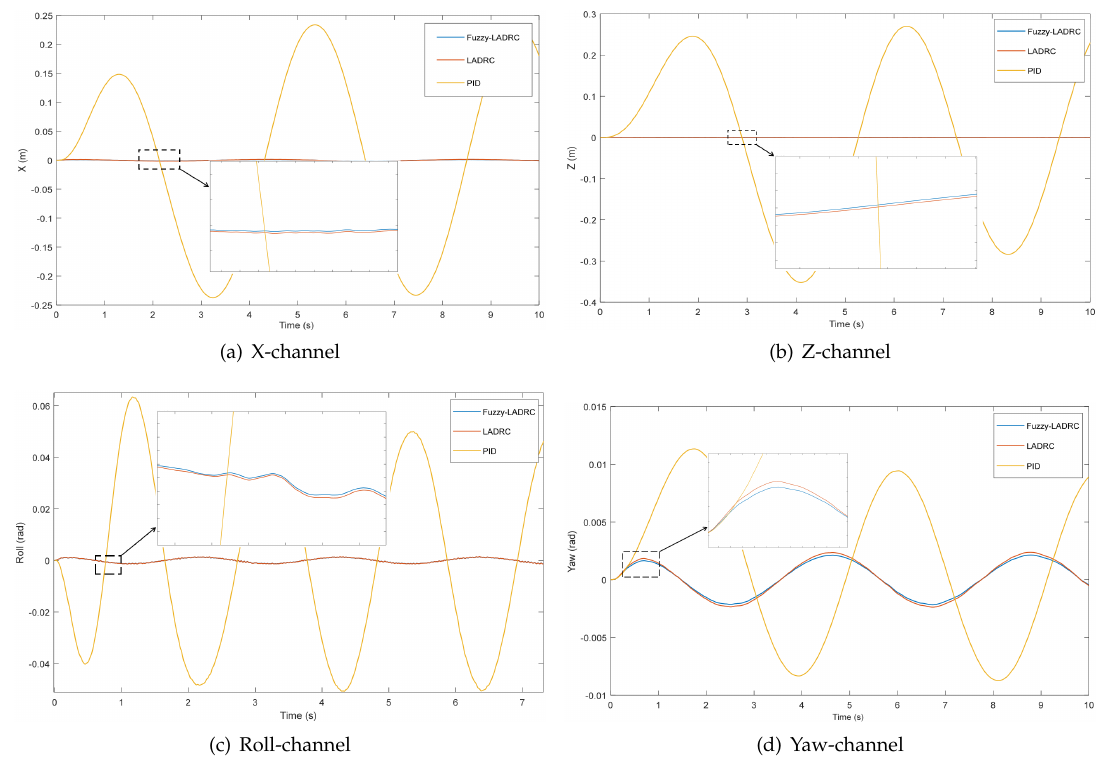
Figure 15. Experimental results of disturbance (2).